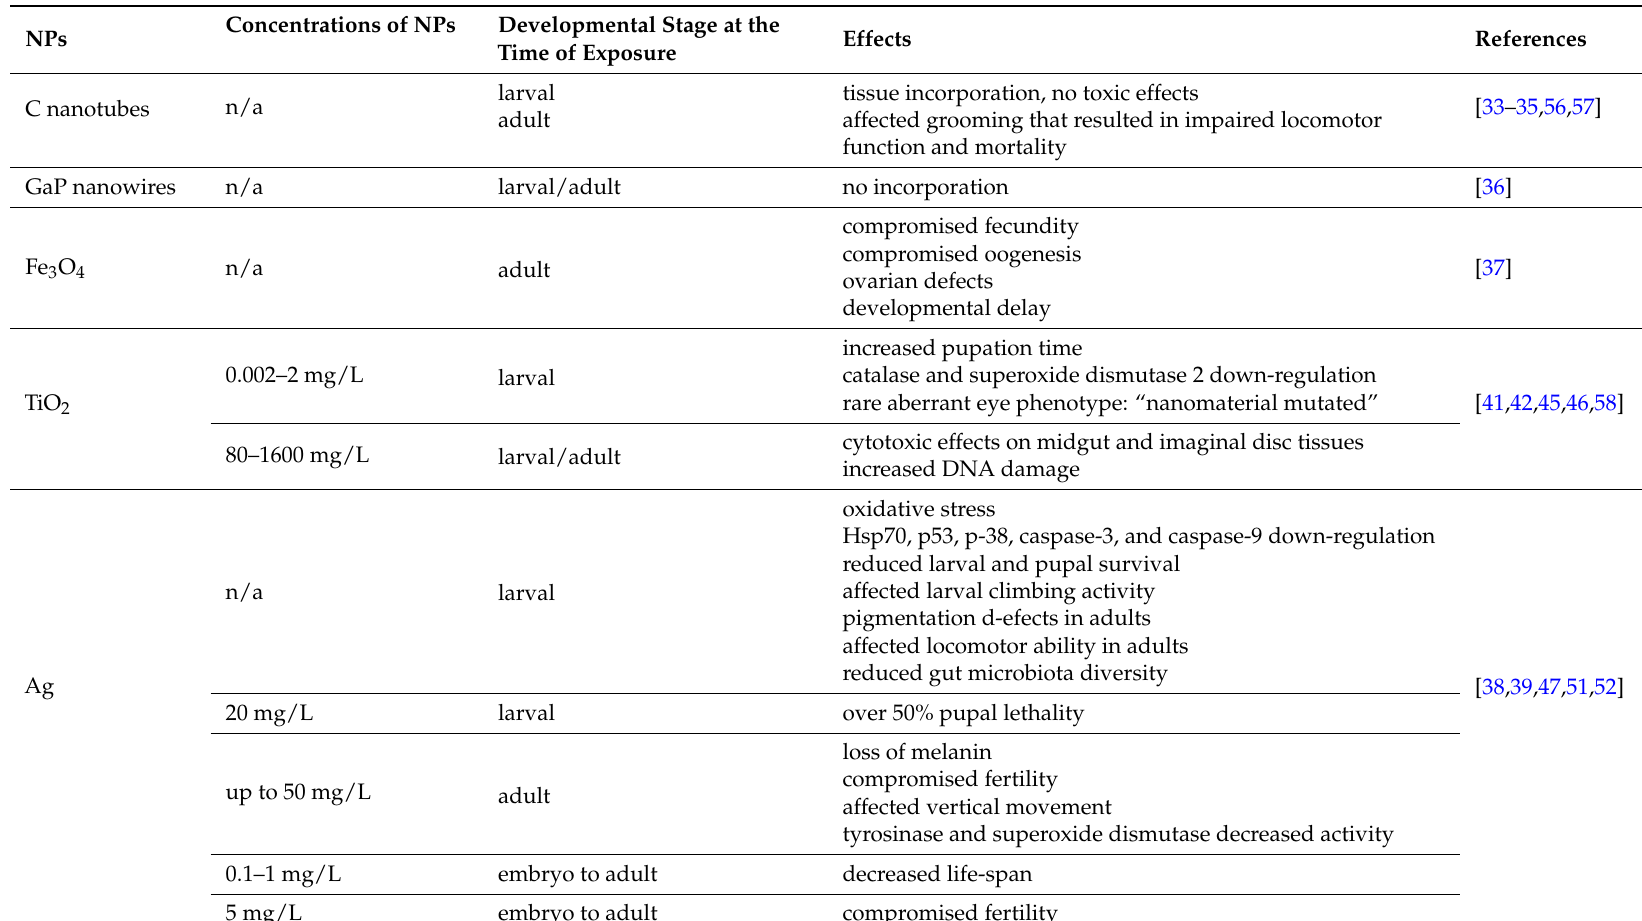
Table 1. The effects of different types of NPs on D. melanogaster experimental